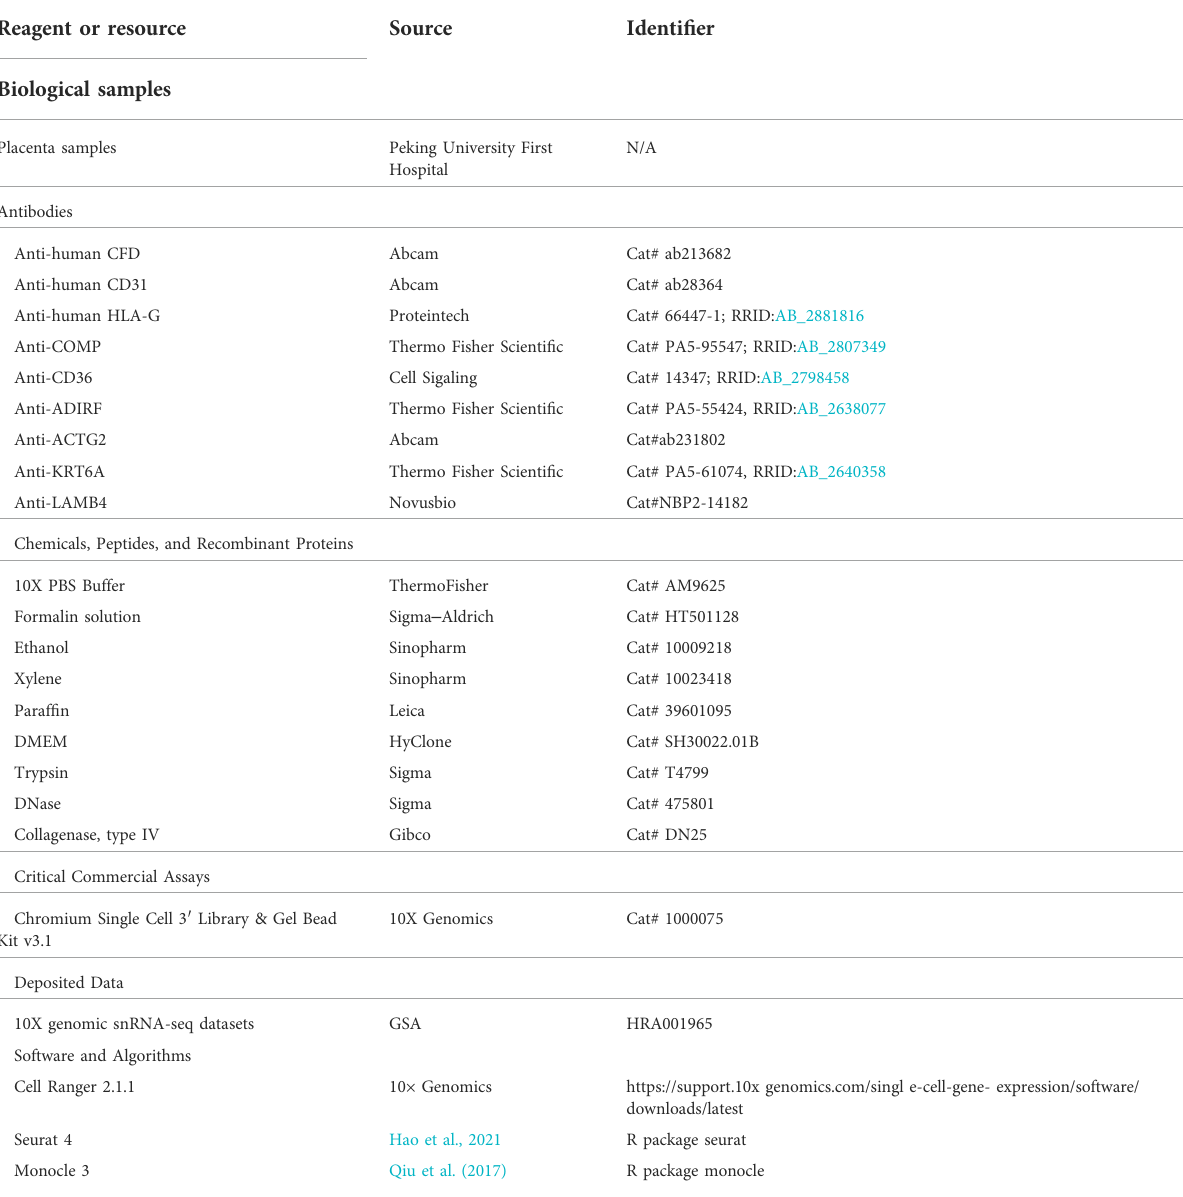
TABLE 1 Resource Identi fi cation